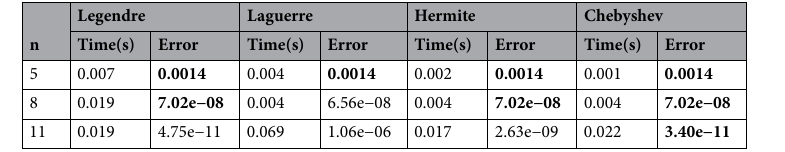
Table 9. Comparision of maximum relative error for Example 7.1 with different numbers of neurons. Significant values are in bold.